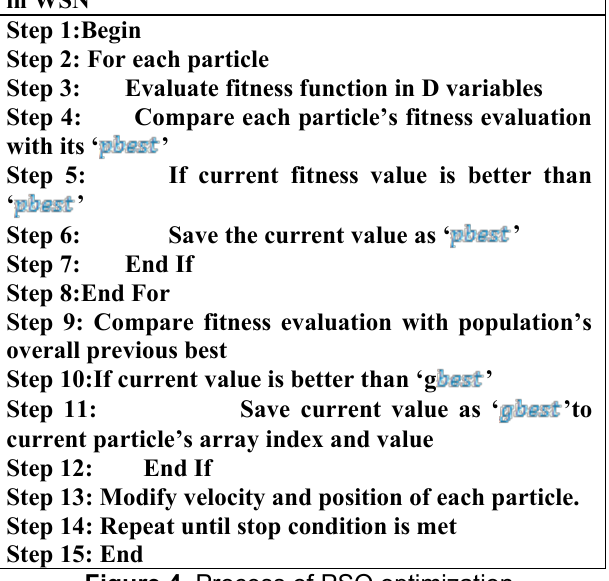
Figure 4. Process of PSO optimization